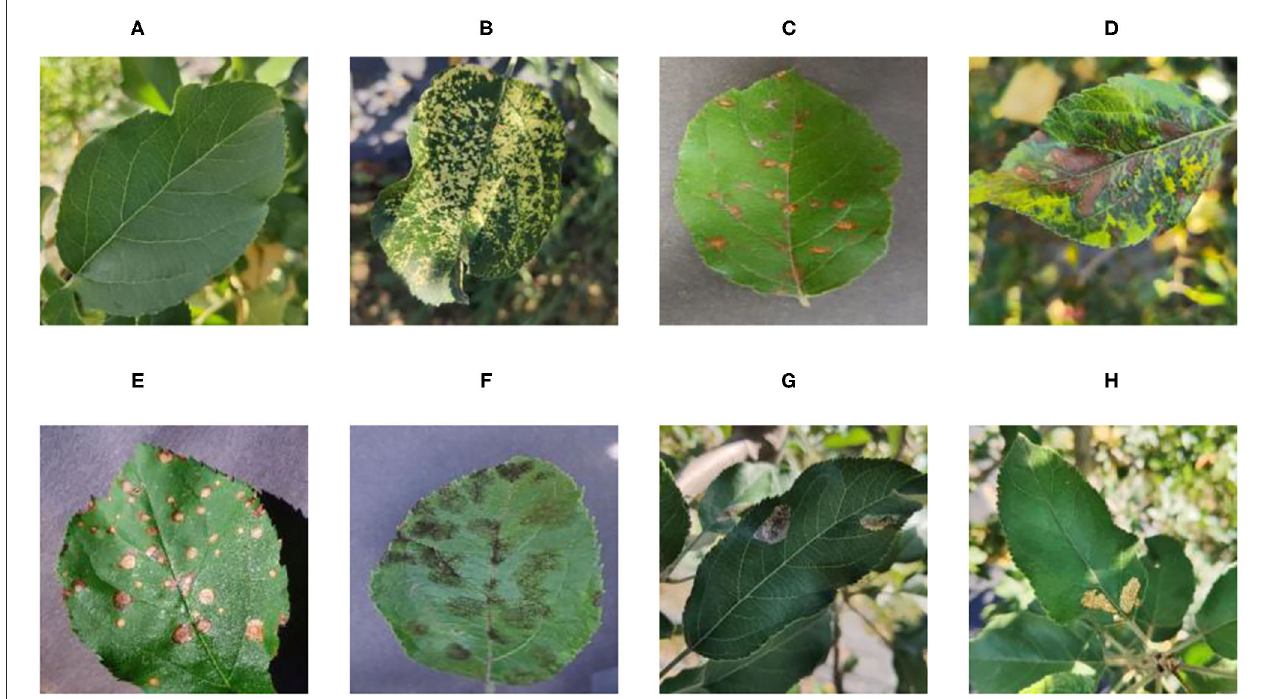
FIGURE 1 | Eight common apple leaf disease types. (A) Healthy, (B) Mosaic, (C) Rust, (D) Glomerella leaf spot, (E) Black rot, (F) Scab, (G) Apple litura moth, and (H) Apple leaf mites.